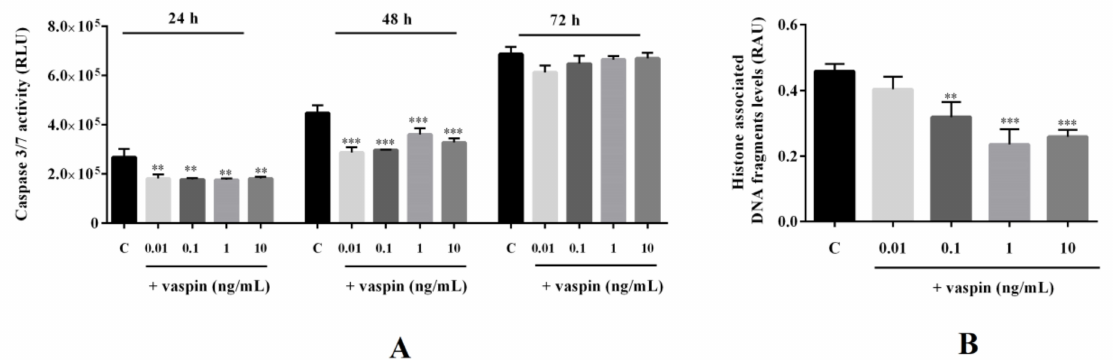
Figure 4. E ff ect of vaspin on caspase-3 and -7 activity and histone-associated DNA fragment levels: The cells were treated with 0.01, 0.1, 1, and 10 ng / mL vaspin for 24, 48, and 72 h, after which caspase-3 and -7 activity ( A ) was analysed using a Caspase-glo 3 / 7 assay or were incubated for 24 h to study levels of histone-associated DNA fragments ( B ) using a cell-death detection kit. Experiments were independently performed and repeated five times ( n = 5). The data are plotted as means ± SEM. Significant di ff erences between control and vaspin treatments are indicated by ** p < 0.01 and *** p < 0.001; Control (C), Relative Luminescence Unit (RLU), Relative Absorbance Unit